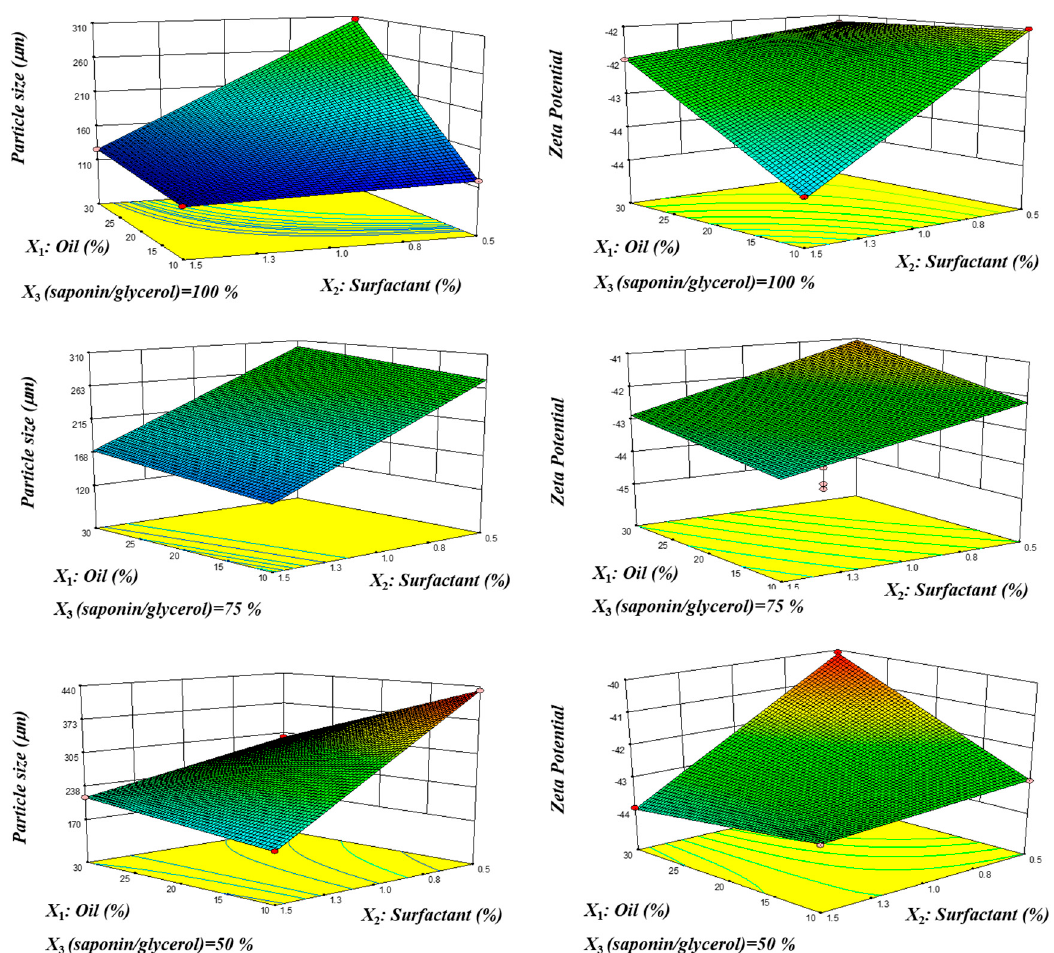
Figure 5. Response surface described by the model established for the particle size (in volume) and zeta potential in the experimental region evaluated: 3D plot and contour plots for oil and surfactant percentages at fixed saponin / glycerol percentages (minimum, central, and maximum). For representation purposes, the O / W ratio was considered as oil percentage, e.g., an O / W ratio of 10 / 90 is represented as 10% oil.